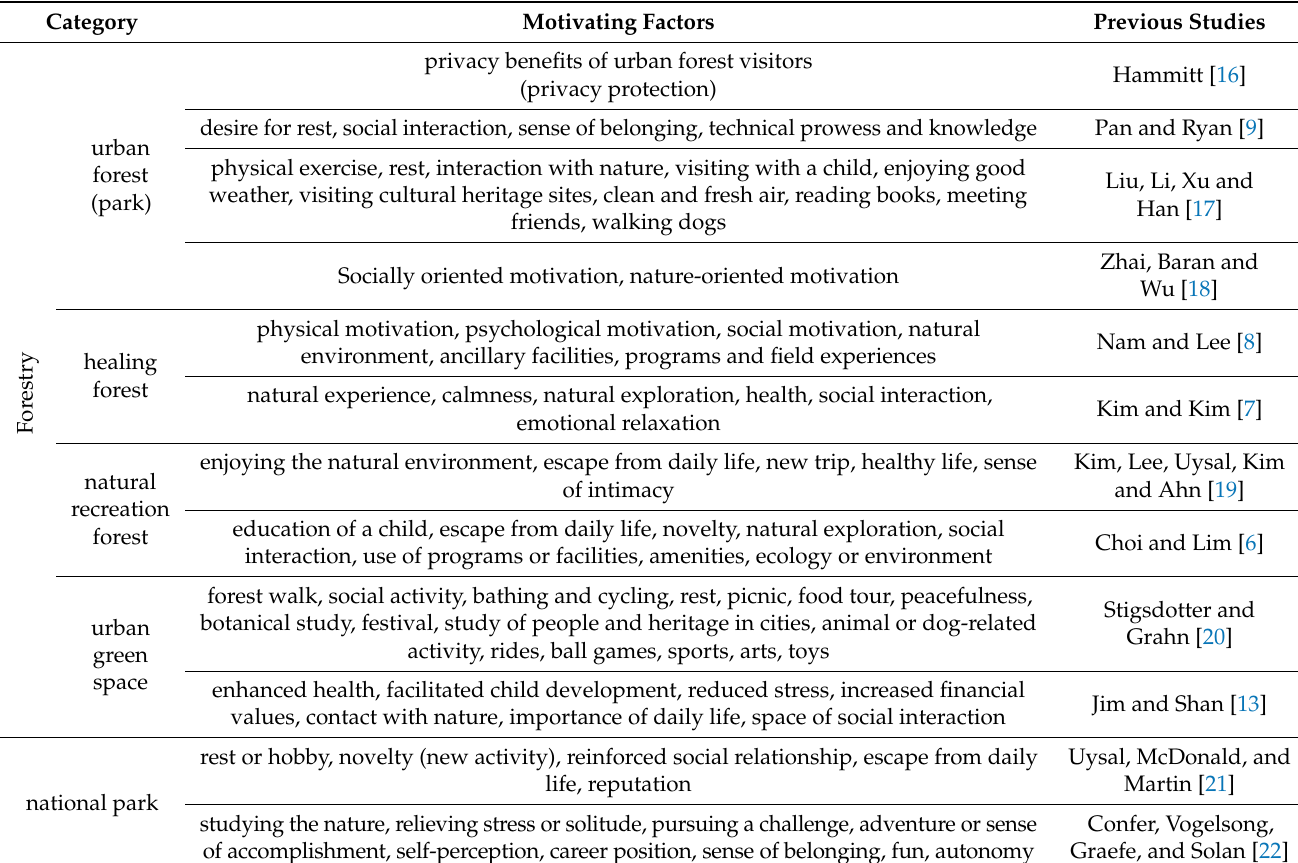
Table 1. The factors that motivate the visit to urban